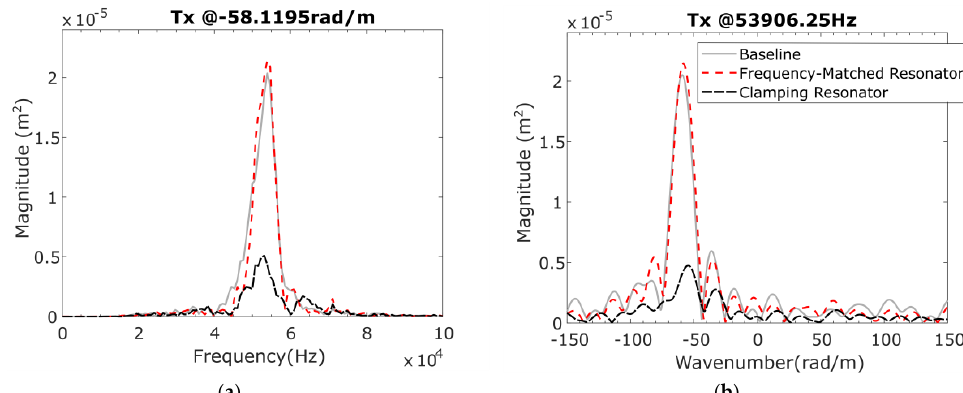
Figure 4. ( a ) The frequency spectra of the transmitted signal, which were extracted from the 2DFFTs shown in Figure 2 at a wavenumber of − 58.1 rad/m; ( b ) The wavenumber spectra of the transmitted signal, which were extracted from the 2DFFTs shown Figure 2 at a frequency of 53.9